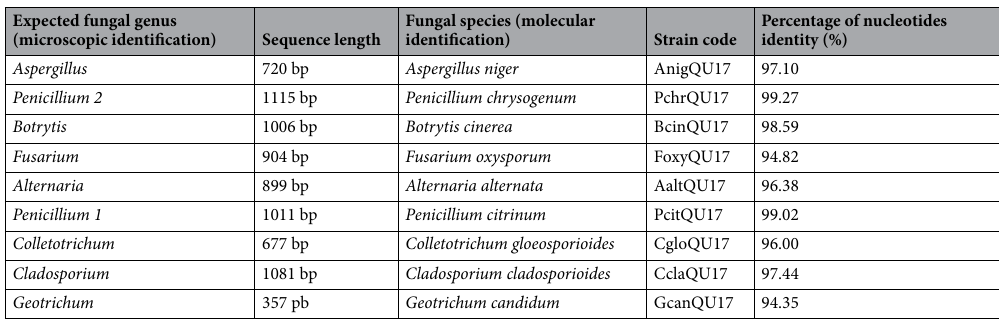
Table 1. PCR products blasting results indicating species of fungal isolates used.